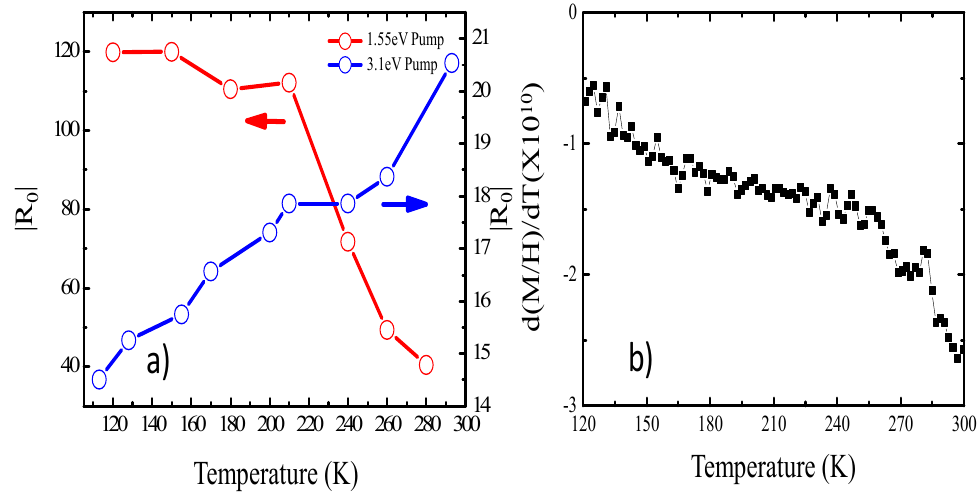
Figure 3. ( a ) The amplitude of the negative peak (|R 0 |) as a function of temperature. The red dotted line shows the temperature dependence of Δ R peak of 1.55 eV pump corresponding to the d-d transition for Mn, and the blue dotted line shows the temperature dependence of Δ R peak of 3.1 eV pump corresponding to the d-d transition for Fe. We note that the error bars are comparable to the size of the data points and are therefore not shown. ( b ) The d(M/H)/dT curve for the Bi 2 FeMnO 6 film.